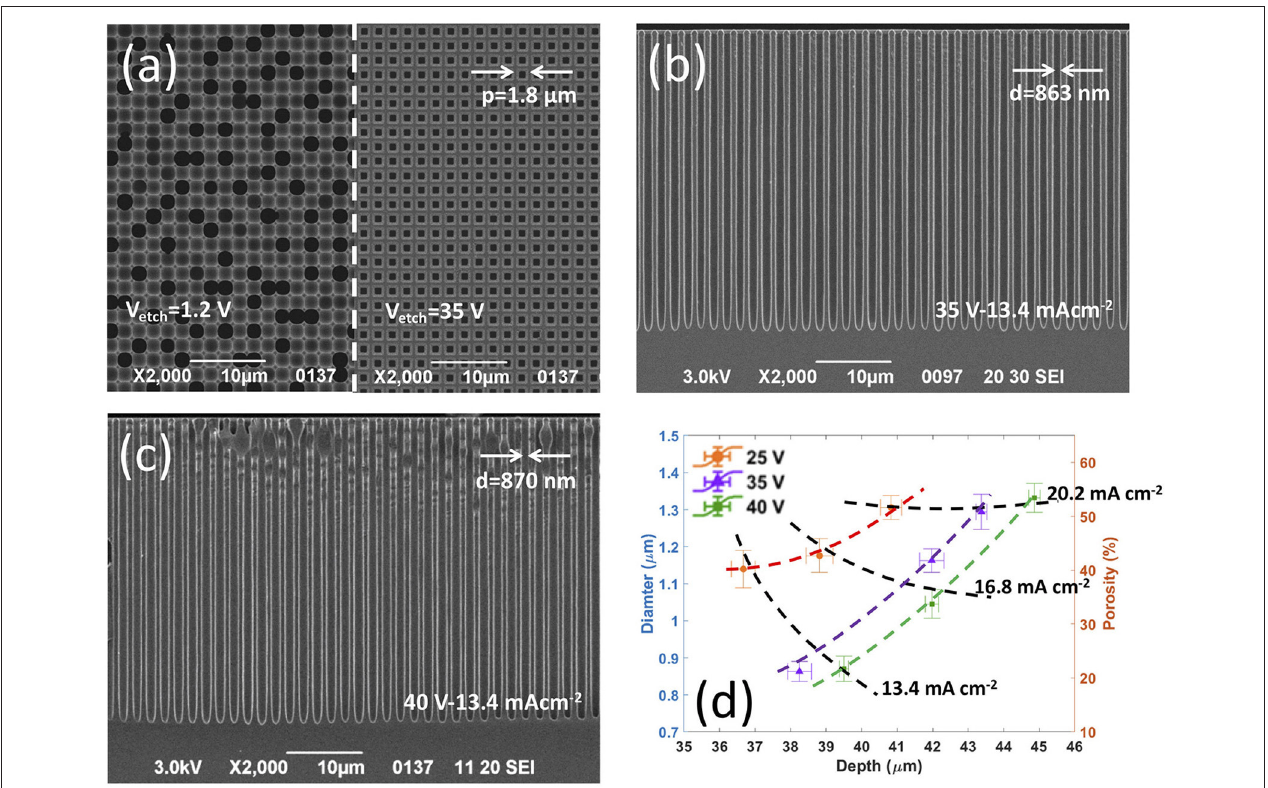
FIGURE 1 | Influence of etching voltage V etch and etching current density J etch 0 value on the controlled etching of pores with sub-micrometric diameter and spacing of 1.8 µ m. (a) Top-view SEM images showing (left side) the uncontrolled etching resulting by performing the BIEE with V etch = 1.2V and J etch 0 = 13.4 mAcm − 2 , and (right side) a uniform array of sub-micrometric ordered pores featuring same diameter and depth, successfully achieved increasing the V etch value to 35V; (b,c) cross section SEM images showing uniform arrays of sub-micrometric ordered pores featuring same diameter and depth successfully obtained by BIEE performed with (b) V etch = 35V and J etch 0 = 13.4 mAcm − 2 , and (c) V etch = 40V and J etch 0 = 13.4 mAcm − 2 . (d) Morphological investigation of fully-uniform arrays of ordered pores etched at high anodic voltages, in terms of pore diameter, porosity, and depth: average values and standard deviations (error bars) of pore diameter (left axis) with corresponding experimental porosity (right axis) as a function of pore depth (average values and standard deviations) for each of the V etch and J etch 0 values